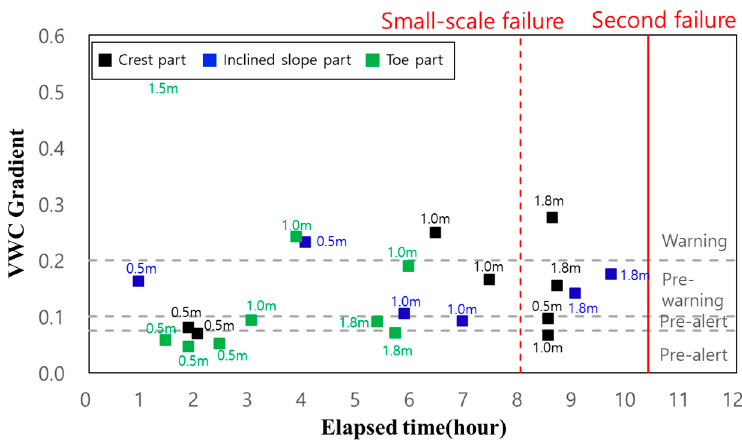
Figure 16. Variation of the VWC gradient as a function of time (second experiment).